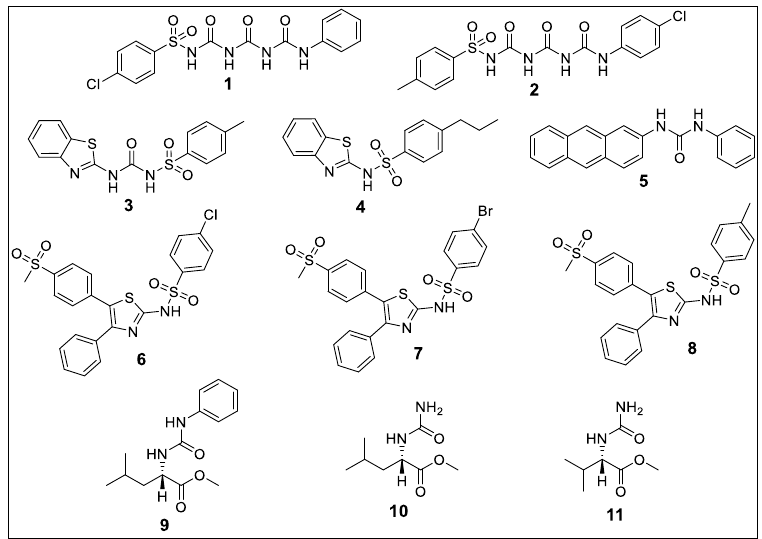
Figure 3. Structures of all synthesized compounds ( 1 to 11 ).